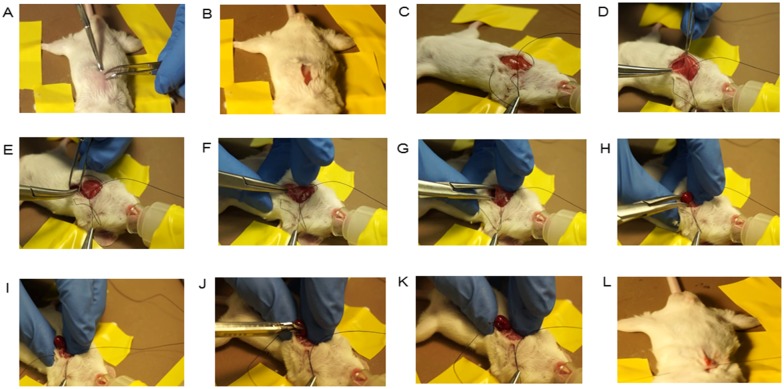
Various stages of clip method.(A): Placing the unconscious mouse on a warm pad and shaving in the area of the precordial chest; (B): A small skin cut was made in the middle position of precordial chest; (C): a purse suture was made; (D) Dissecting and retracting the pectoral major and minor muscle to expose the 4th intercostal space; (E): Placing the mosquito clamp at the 4th intercostal space with the help of forceps; (F): Forcing the mosquito to open the pleural membrane and pericardium at the 4th intercostal space; (G) & (H): With the clamp slightly open and finger strength, the heart was smoothly and gently “popped out” through the window; (I)–(K): Once the LAD was located, an automatic clip applier was used to dispense a clip to ligate the LAD with a ~60–90 degree angle along the heart long axis; (L): Placing the heart back in to the intra-thoracic space promptly after ligation, therewith manual evacuation of air and closure of muscle and the skin by the pre-placed purse-string suture.